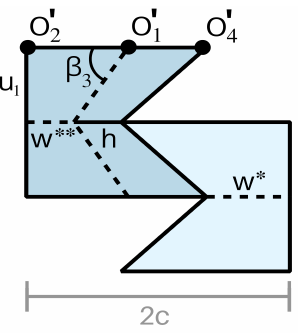
Figure 9. S 1 and S 4 in a symmetric smooth sheet